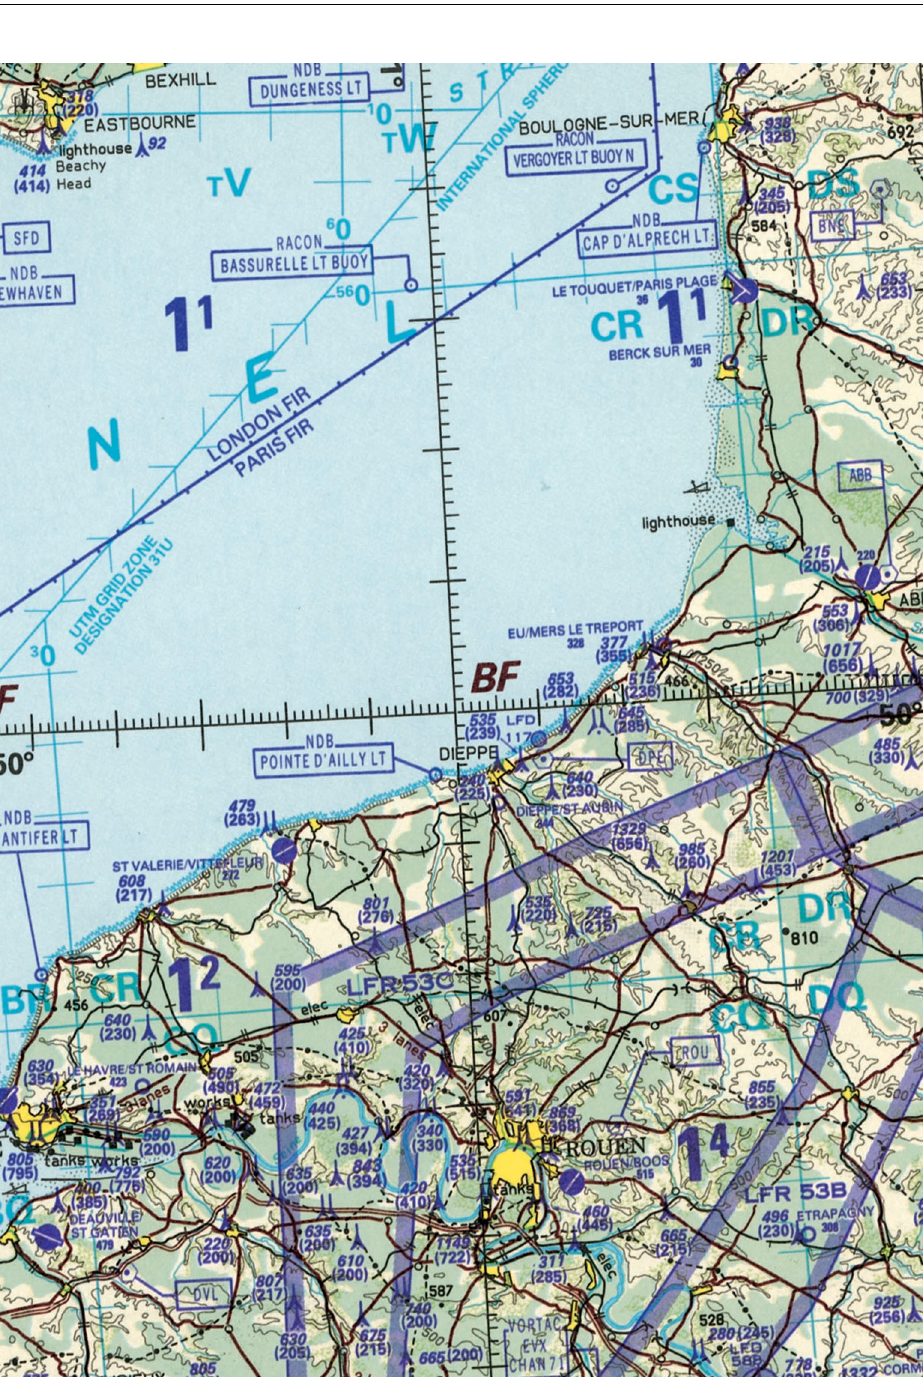
Fig. 14. Operational Navigational Chart , 1:1,000,000 – ONC